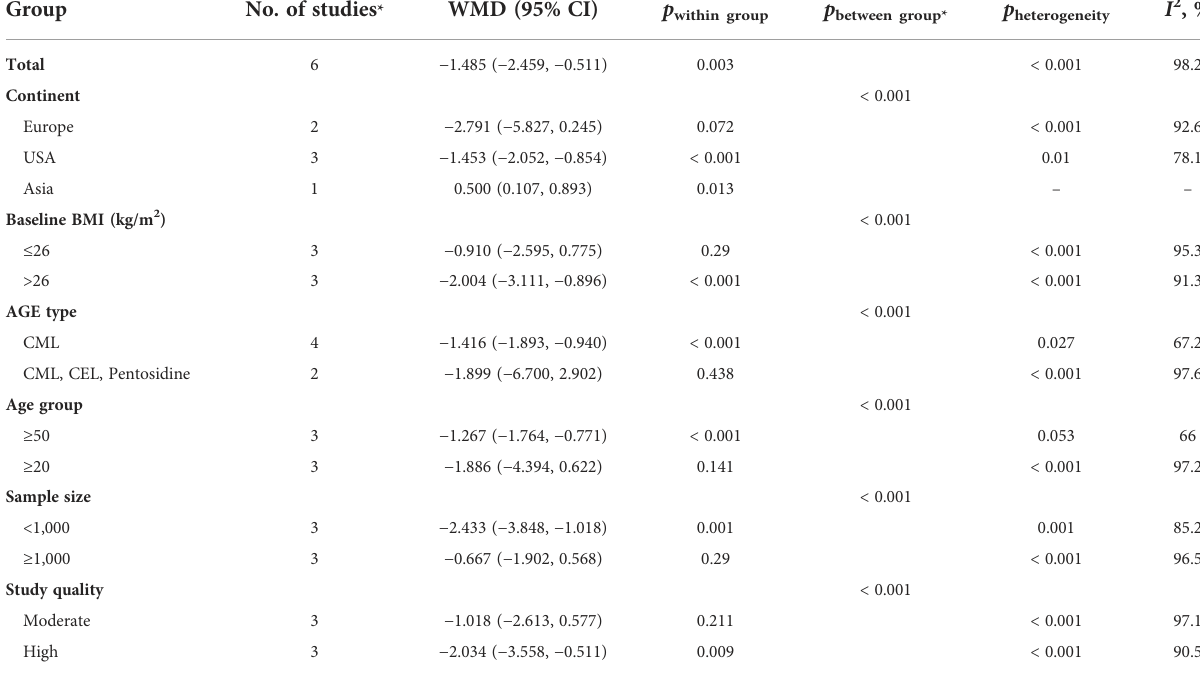
TABLE 4 Subgroup analysis for the comparison of BMI between highest versus lowest category of circulating AGE. Group No. of studies * WMD (95% CI) p within group p between group* p heterogeneity I 2 , %